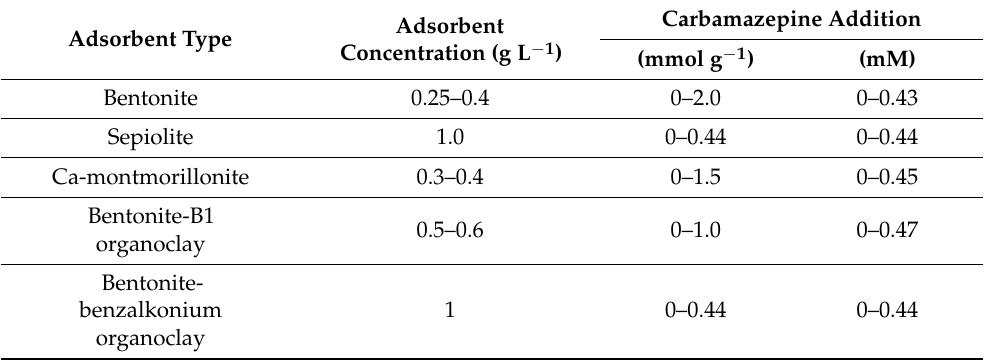
Table 1. Detailed adsorption experiments’